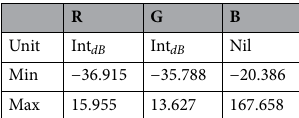
Table 3. Statistical summary of σ